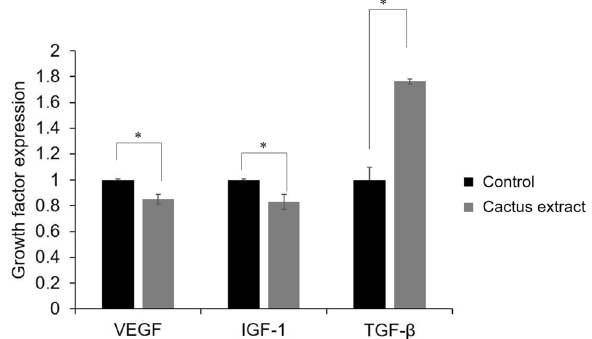
Figure 7. Effect of cactus extract (flesh) on growth factors of IBMX-induced B16-F10 cells. All data are presented as the mean ± S.D. of three independent